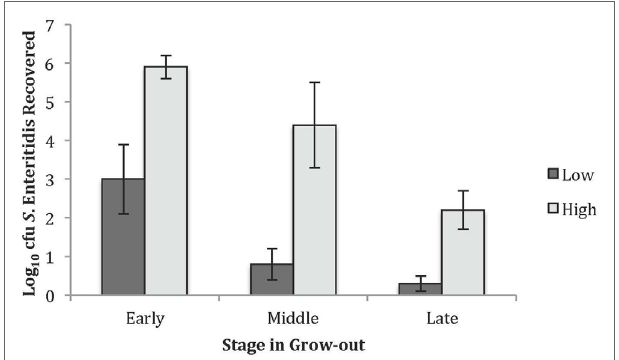
FigUre 1 | Recovered Salmonella Enteritidis in the high and low groups used for the peptide and antibody arrays. The average Log 10 colony forming units recovered for the low and high S . Enteritidis groups at the early, middle, and late